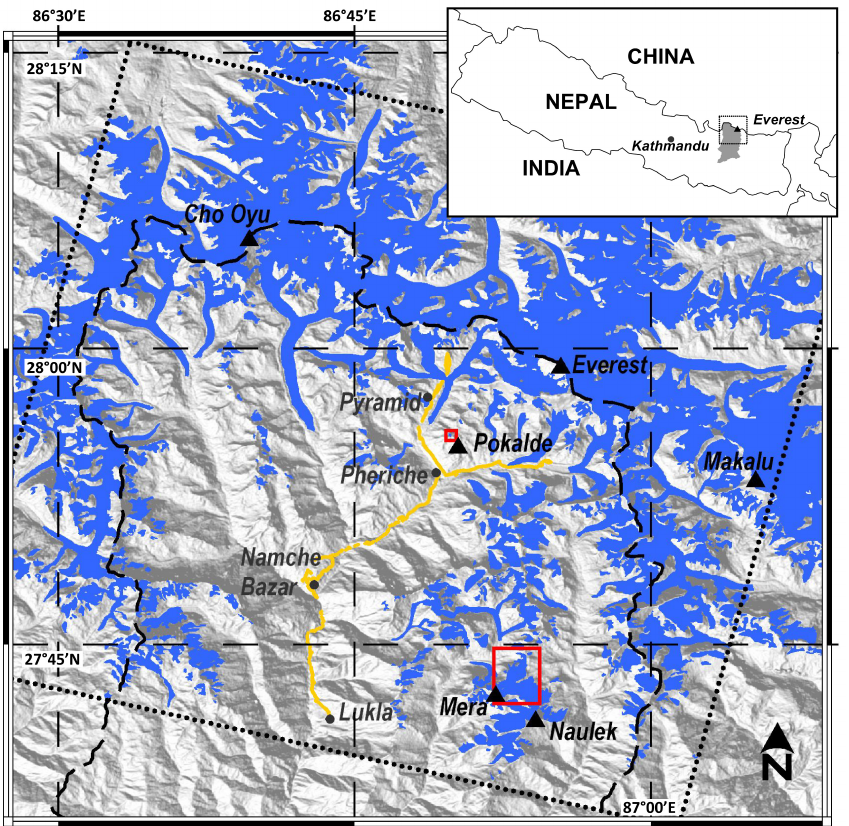
Fig. 1. Map of the high Dudh Koshi basin (in grey in the inset map of Nepal and with limits represented by the dashed black line in the main map) where Mera and Pokalde glaciers are located (inside the red squares). Meteorological stations and main summits are indicated by dots and triangles respectively. Glacierized areas from the Randolph Glacier Inventory v2.0 (Arendt et al., 2012) are represented in blue. The dotted line locates the footprint of the SPOT5-HRG image. In orange, a kinematic DGPS survey performed in April 2011 along the trail of the Everest Base